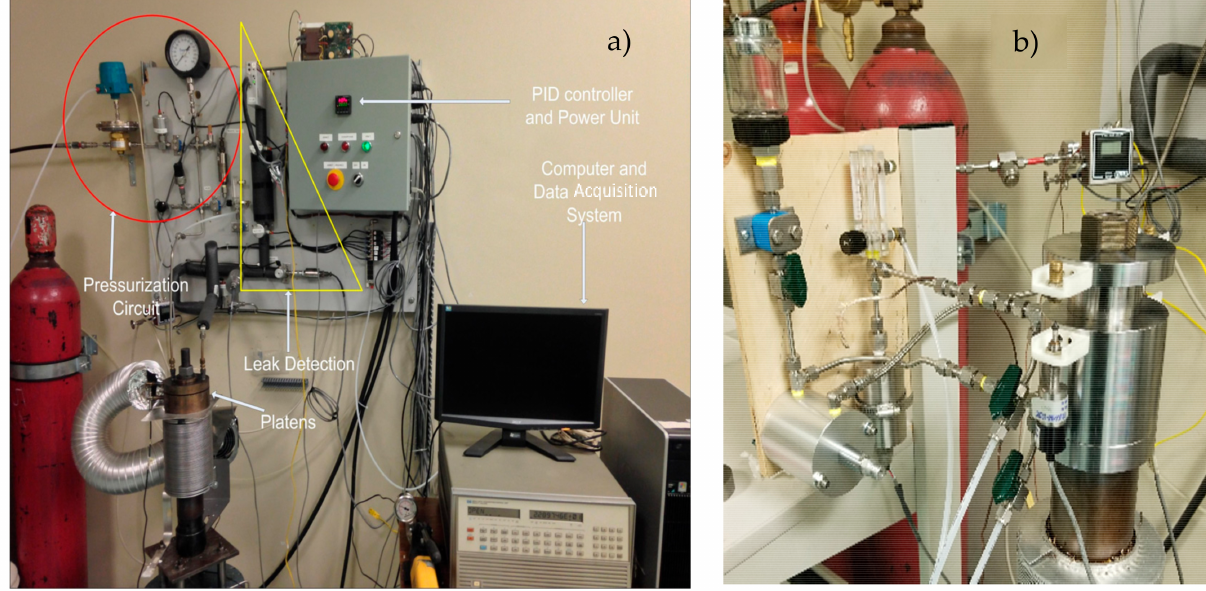
Figure 2. Universal packing test rig: ( a ) gas test module and ( b ) liquid test